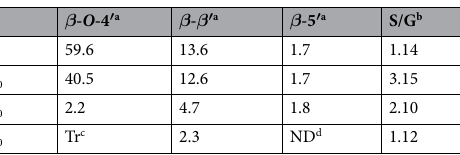
Table 3. Semi-quantification of the lignin fractions L 0 , L 170 , L 200 , and L 210 obtained from Eucalyptus by semi- quantitative 2D-HSQC NMR. a Results expressed per 100 Ar based on semi-quantitative 2D-HSQC spectra. The C α –H α correlations at δ C / δ H 71.8/4.83 (A α ), δ C / δ H 84.8/4.64 (B α ), and δ C / δ H 86.8/5.47 (C α ) were used for the integration to calculate the percentages of β - O -4 ′ , β - β ′ , and β -5 ′ linkages, respectively. b S/G ratio obtained by the equation: S/G ratio = 0.5 I (S 2,6 )/ I (G 2 ). c Tr, trace. d ND, not